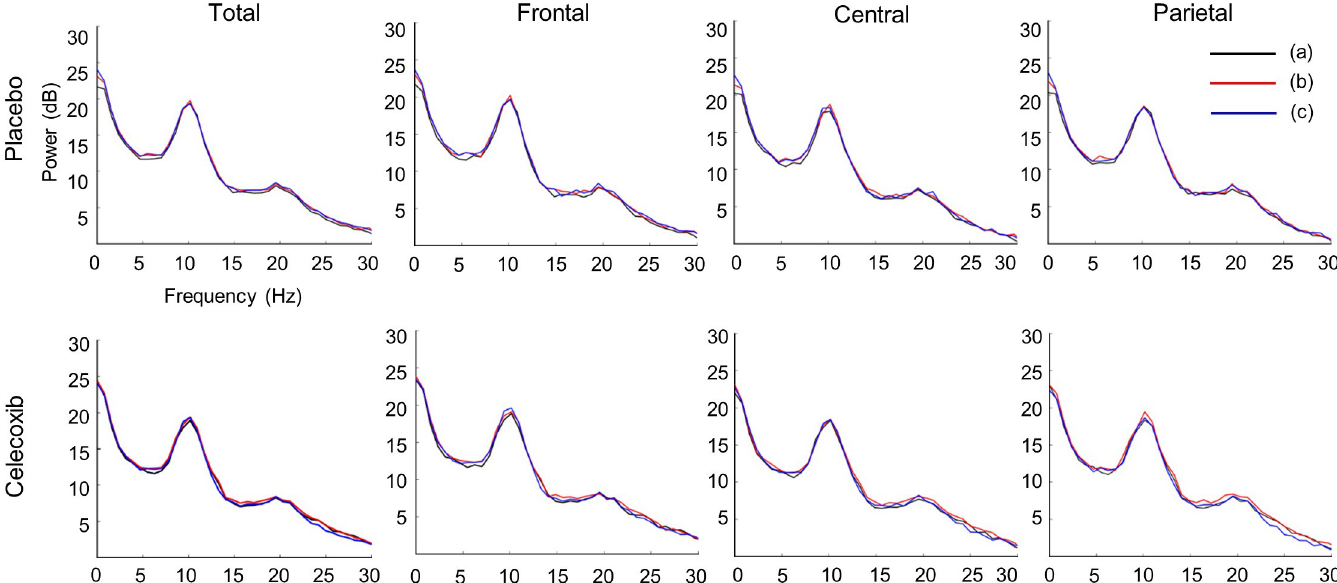
Fig 3. Averaged power spectra of the subjects receiving placebo (upper) or celecoxib (lower) at different recording sites. (a) Baseline, (b) after a single dose of placebo or celecoxib (400 mg), (c) after a 7-day treatment regimen.